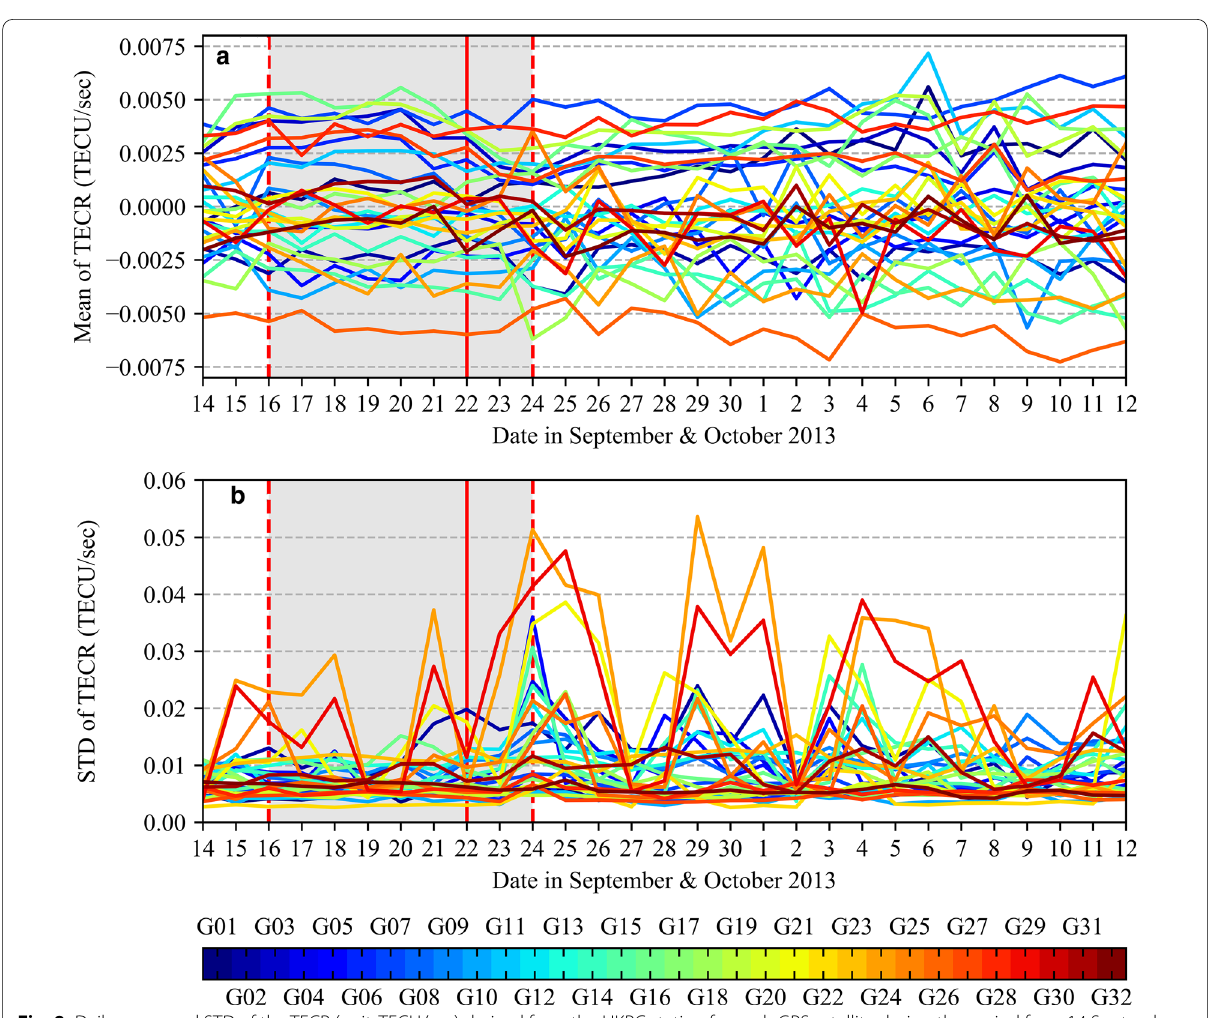
Fig. 8 Daily mean and STD of the TECR (unit: TECU/sec) derived from the HKPC station for each GPS satellite during the period from 14 September to 12 October 2013. Different colors denote different satellites. The life cycle of the Usagi was from 16 to 24 September 2013, as represented by the gray background area between two vertical red dashed lines. The vertical red solid line denotes the TC’s landfall near Hong Kong on 22 September